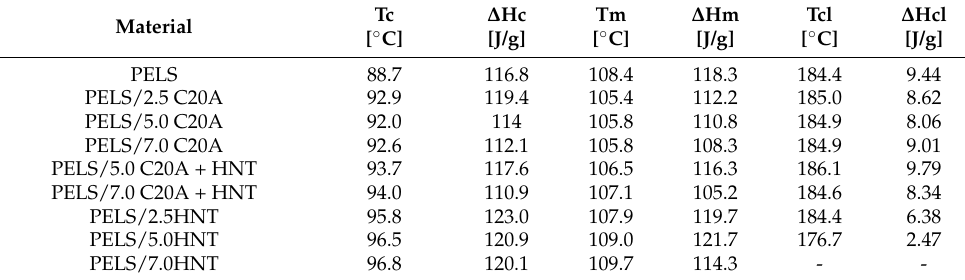
Table 1. Thermal properties of PELS-based nanocomposites.